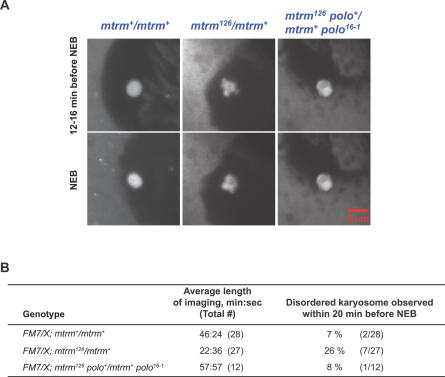

mtrm Is Defective in Karyosome Maturation before NEBThe karyosomes in stage 11–12 oocytes, which have a nuclear envelope, were imaged after the injection of Oli-green and Rhodamine-tubulin until NEB. NEB was defined as the time when the nuclear envelope seems ruffled and the Rhodamine-tubulin enters the nucleus.(A) Representative examples of karyosomes 12–16 min before and at NEB are shown for wild type, mtrm126/mtrm+, and mtrm126 polo+/mtrm+ polo16–1 with achiasmate X chromosomes (FM7/X). Wild type displays a circular karyosome with a smooth outline for 12–16 min before NEB, whereas mtrm126/mtrm+ oocytes bear scabrous or bi-lobed karyosomes. The disordered morphology of karyosomes in mtrm126/mtrm+ oocytes was suppressed by simultaneously reducing the dose of polo. Scale, 5 μm.(B) Summary of karyosome morphology during the 20 min before NEB.